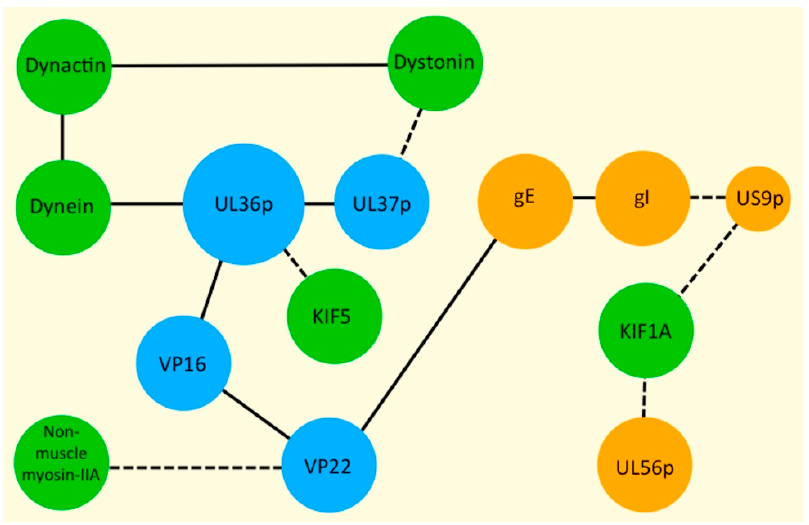
Figure 1. Interactions between alphaherpesvirus and host-cell proteins. Virally encoded tegument and membrane-imbedded proteins are shown in blue and orange, respectively. Host-cell proteins, or protein complexes, are in green. Solid lines indicate direct protein-protein interactions known to occur in alphaherpesvirus-infected cells. Broken lines represent interactions that may be indirect, or where a proposed protein–protein interaction has yet to be demonstrated in the context of a virally infected cell. See text for